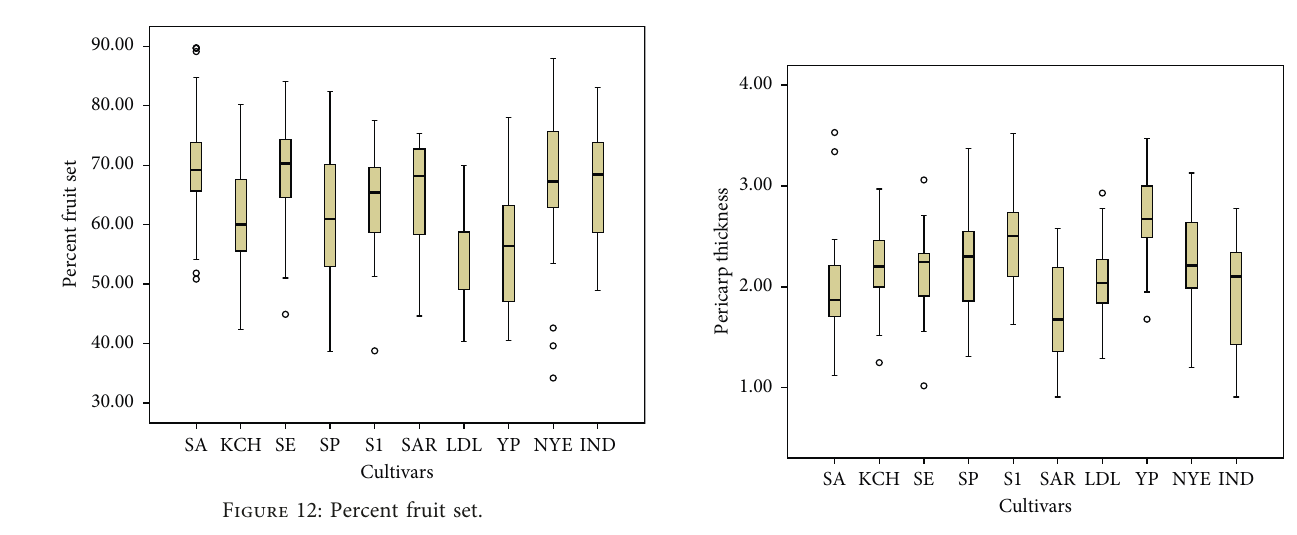
Figure 15: Pericarp thickness (mm).